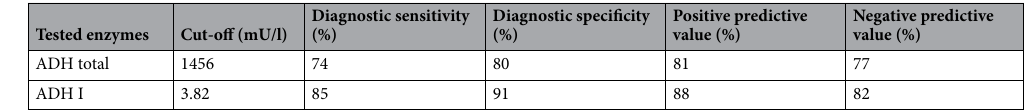
Table 3. Diagnostic criteria for ADH total and ADH I for ICP. The cut-off points were obtained from a study of a health population (95th percentile).